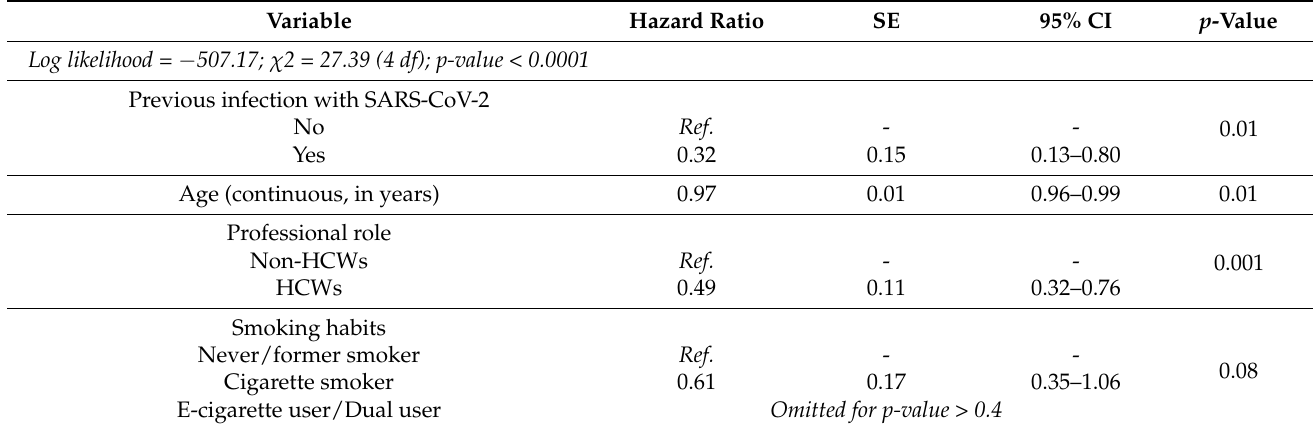
Table 2. Cox multivariate regression model indicating associations between the occurrence of break- through infection with SARS-CoV-2 and characteristics evaluated (N = 309).